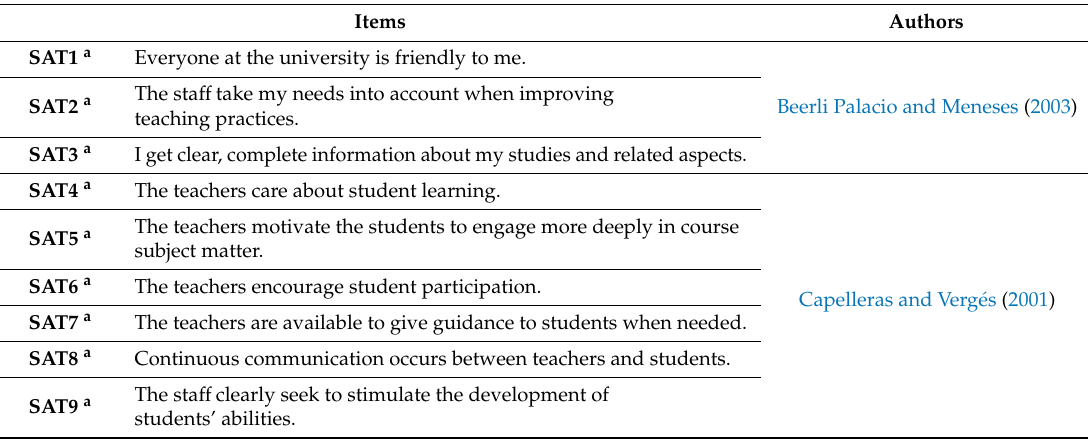
Table 4. Indicators of student